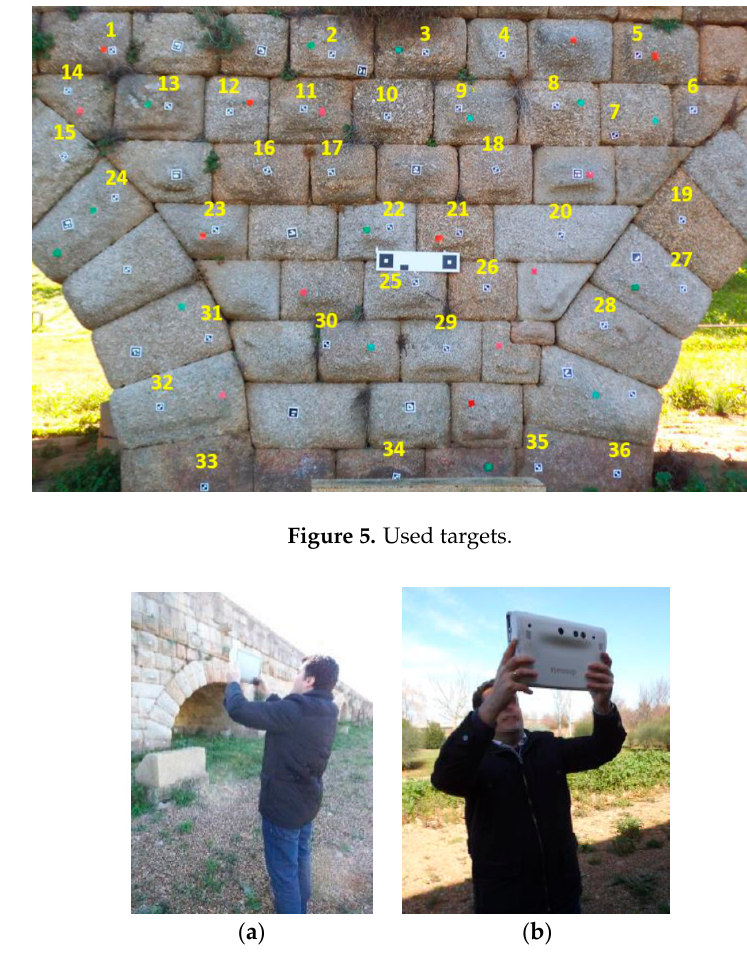
Figure 6. Data capture using EM: ( a ) front view; and ( b ) back view.